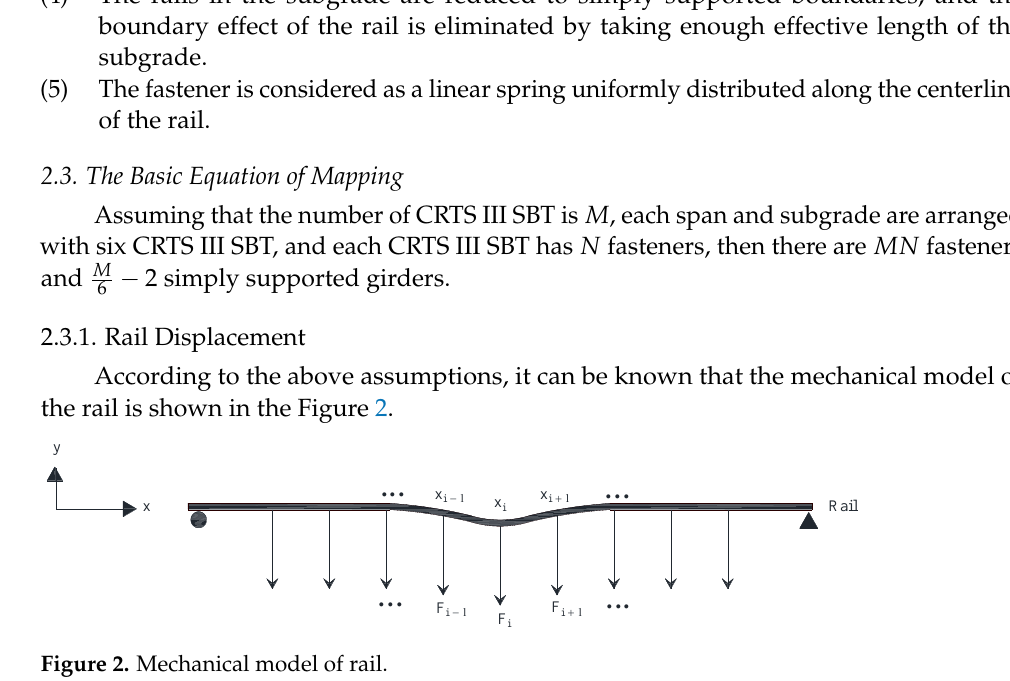
Figure 2. Mechanical model of rail.